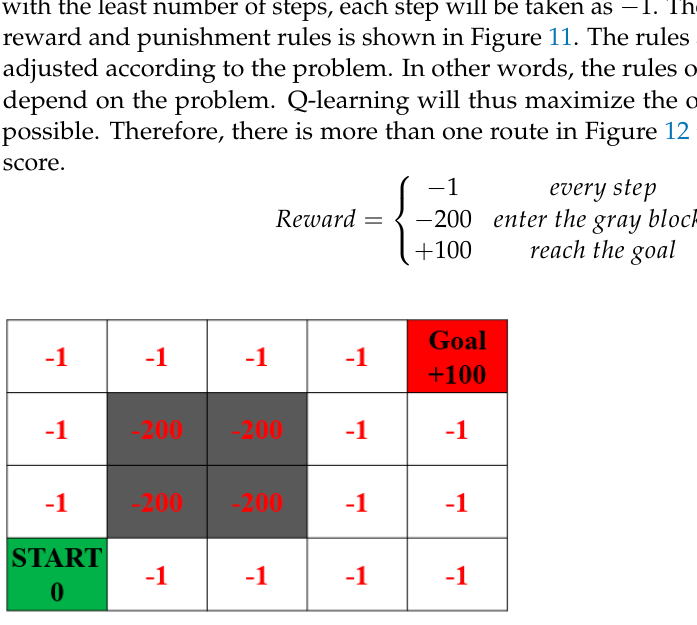
10 of 33 Figure 10. Flowchart of the Q-learning algorithm.